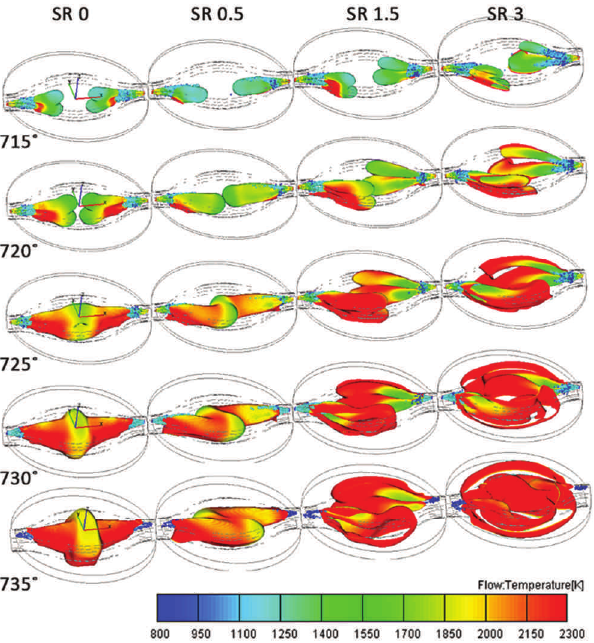
Fig. 5. Injection and combustion visualisation for 4 different swirl ratios and different crank angle potions